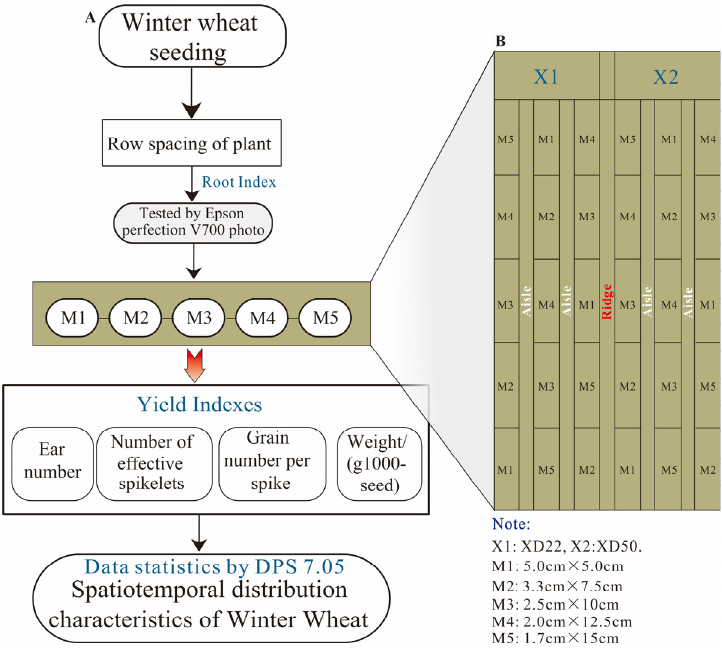
Figure 2. Experimental method Technical route. ( A ) Experimental design and process framework. ( B ) Split-plot experimental design.